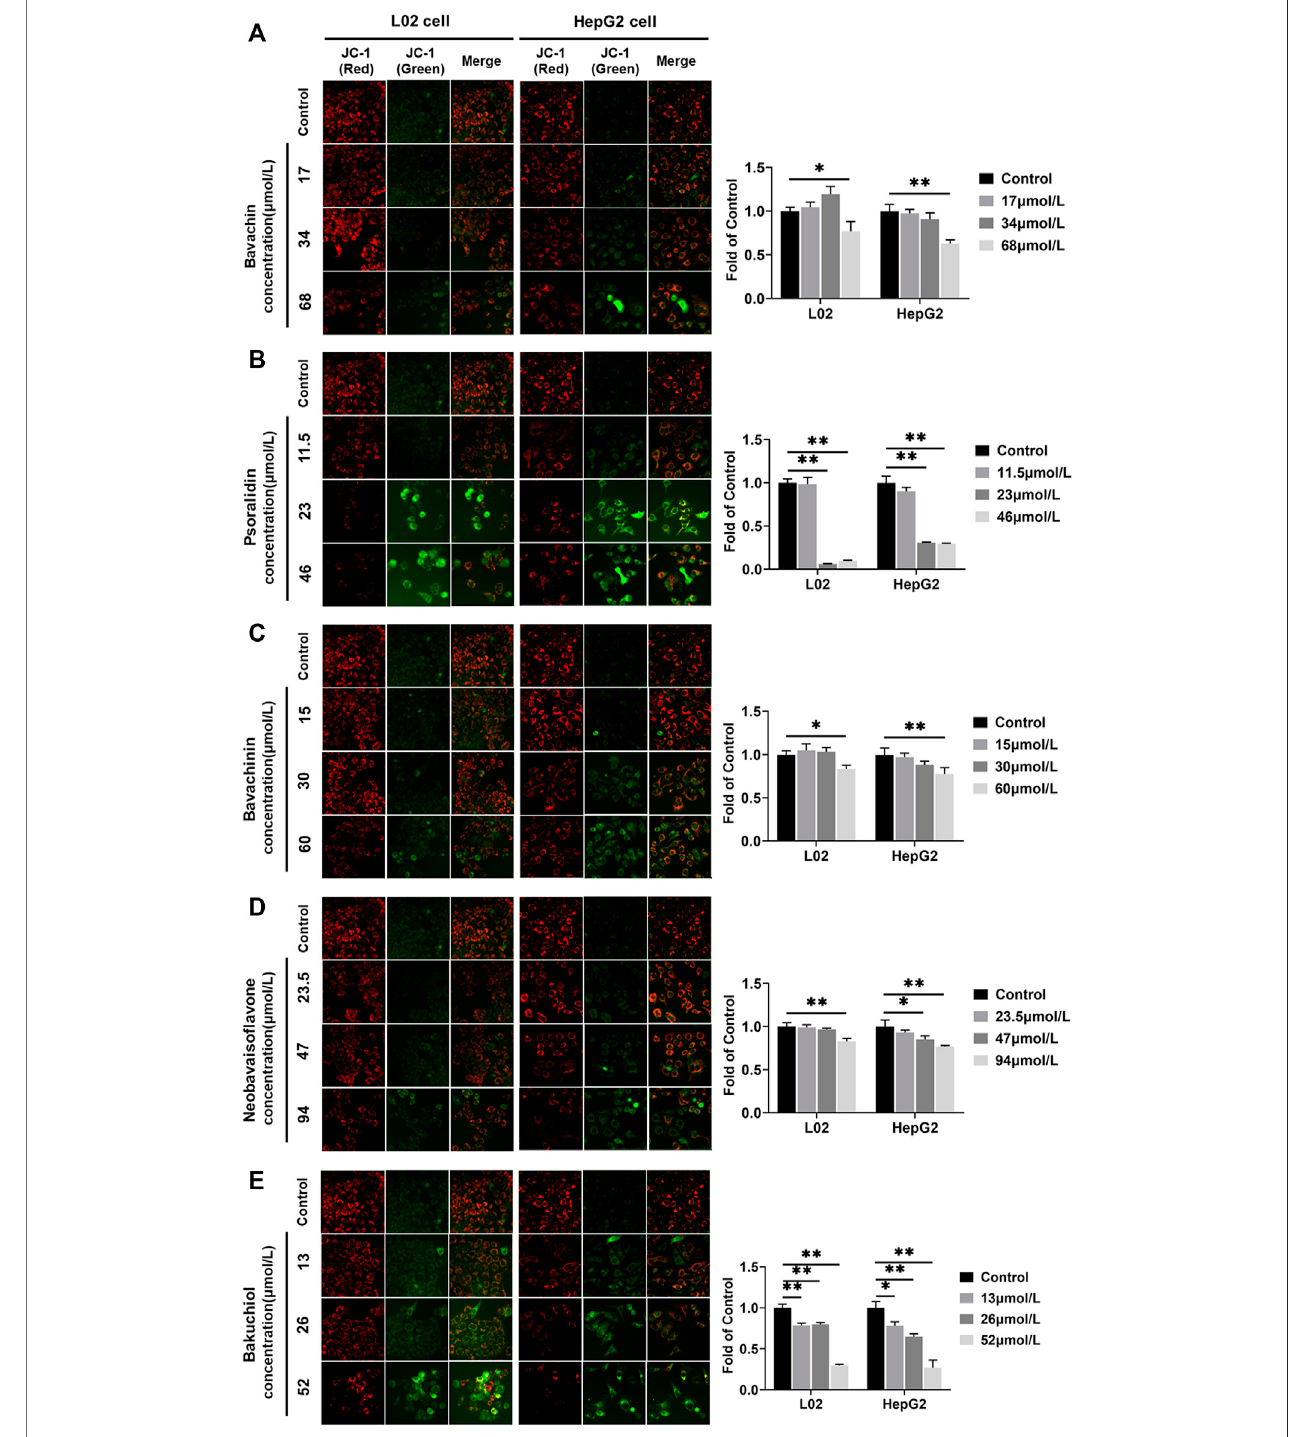
FIGURE 10 | MMP was examined and quanti fi ed using JC-1 staining assays after fi ve compounds were exposed in L02 and HepG2 cells. (A) Bavachin; (B) psoralidin; (C) bavachinin; (D) neobavaiso fl avone; (E) bakuchiol. All values are presented as mean ± SD and n (cid:1) 3. * p < 0.05 and ** p < 0.01 versus the control group. MMP, mitochondrial membrane